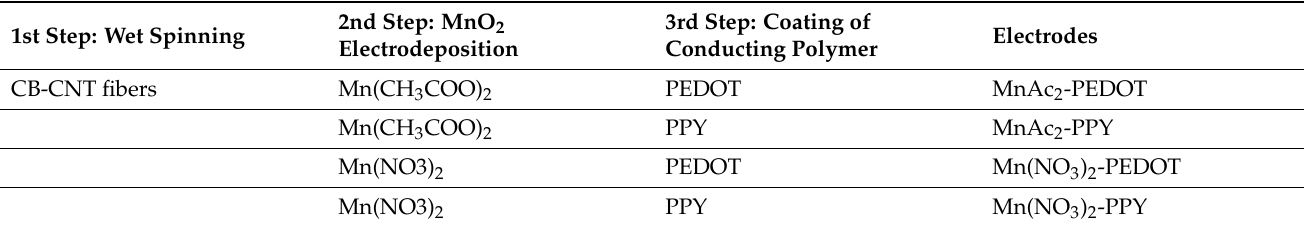
Figure 5. The coaxial wet spinning assembly process, showing fabricated yarn SCs (YSCs), their morphology, and their electrochemical performance. ( a ) Schematic of coaxial spinning. ( b – d ) SEM images of RGO + CNT@CMC. ( e – g ) SEM images of two-ply SCs in ( e ) cross-sectional view and ( f ) side view. The arrow in ( e ) is a PVA/H 3 PO 4 electrolyte, and the inset of ( f ) shows the schematic illustration of the yarn SCs. ( g ) SEM image of a two-ply yarn SC knot. ( h – j ) Electrochemical performances of yarn SCs, ( h ) with the dependence of CA and CV on the charge–discharge current density for RGO@CMC (3, 4), CNT@CMC (5, 6), and RGO + CNT@CMC (1, 2) YSCs. ( i ) Nyquist plots, ( j ) showing the normalized capacitance (C/C 0 , where C 0 is the initial capacitance) versus cycle number for RGO@CMC (left), CNT@CMC (middle), and RGO + CNT@CMC (right) YSCs. Scale bars: 20 µ m for ( b ), 10 µ m for ( c ), 0.2 µ m for ( d ), 50 mm for ( e ), 500 mm for ( f ), 200 mm for ( g ), 3 mm for left, and 0.3 mm for middle and right ( j ). Reproduced with permission from [29]. Table 3. Fabrication steps to make symmetric supercapacitors. Reproduced with permission from